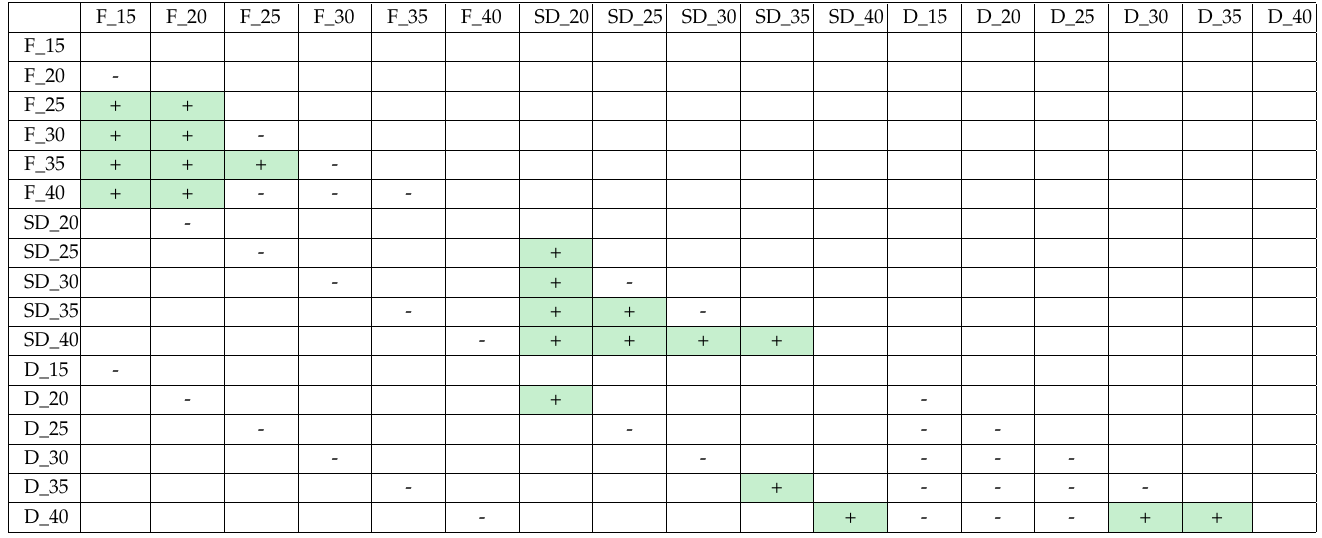
Table A1. SED Significance, plus (+) and green background indicates significant differences, minus (-) indicates statistically insignificant differences.